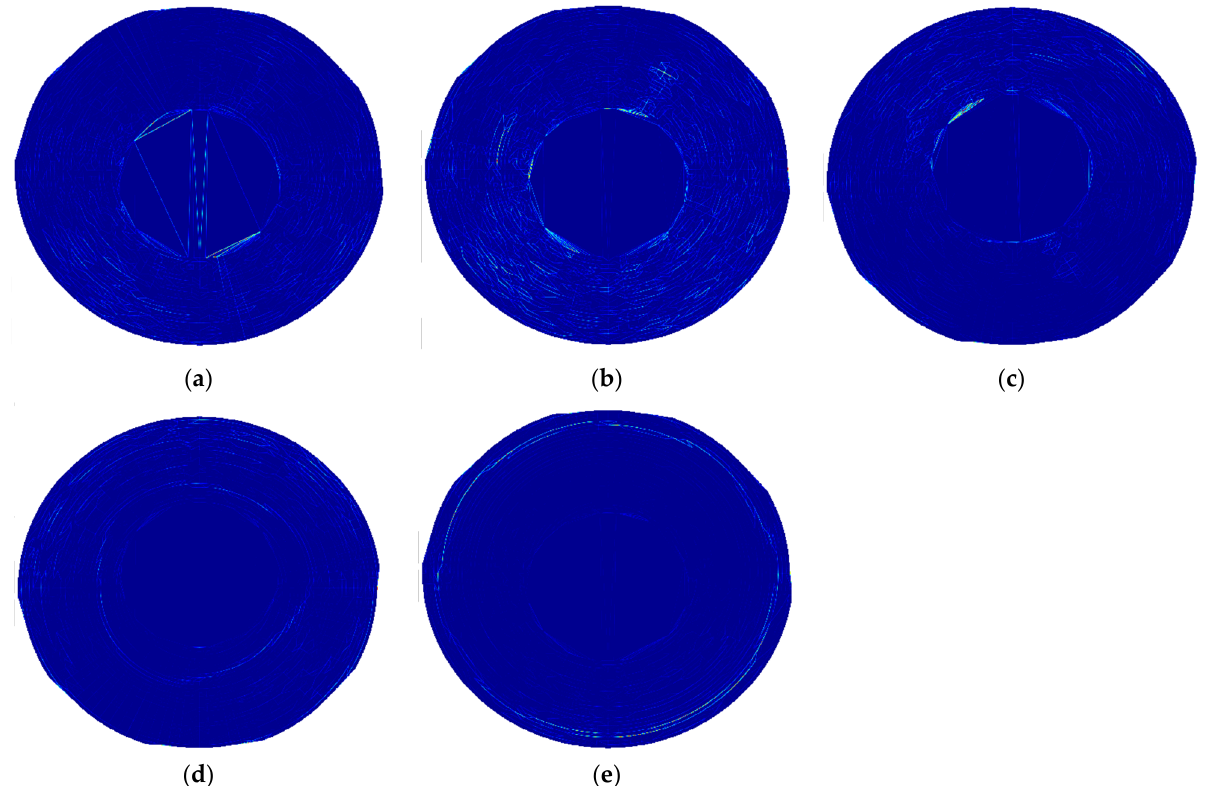
Figure 10. The post-processed mode shapes of the larger disk: ( a – e ) subsequent considered mode shapes.